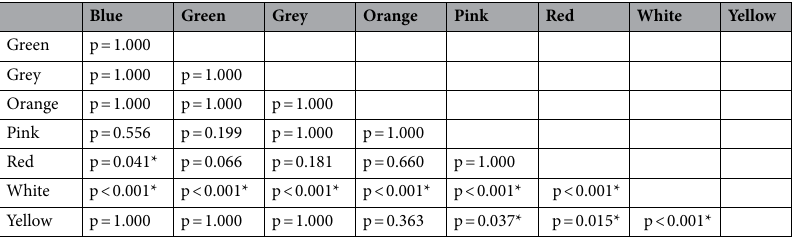
Table 2. Post-hoc differences in the pain ratings for all colors (both modalities merged). The Bonferroni correction was used for all post-hoc tests. Significant comparisons are marked with *.